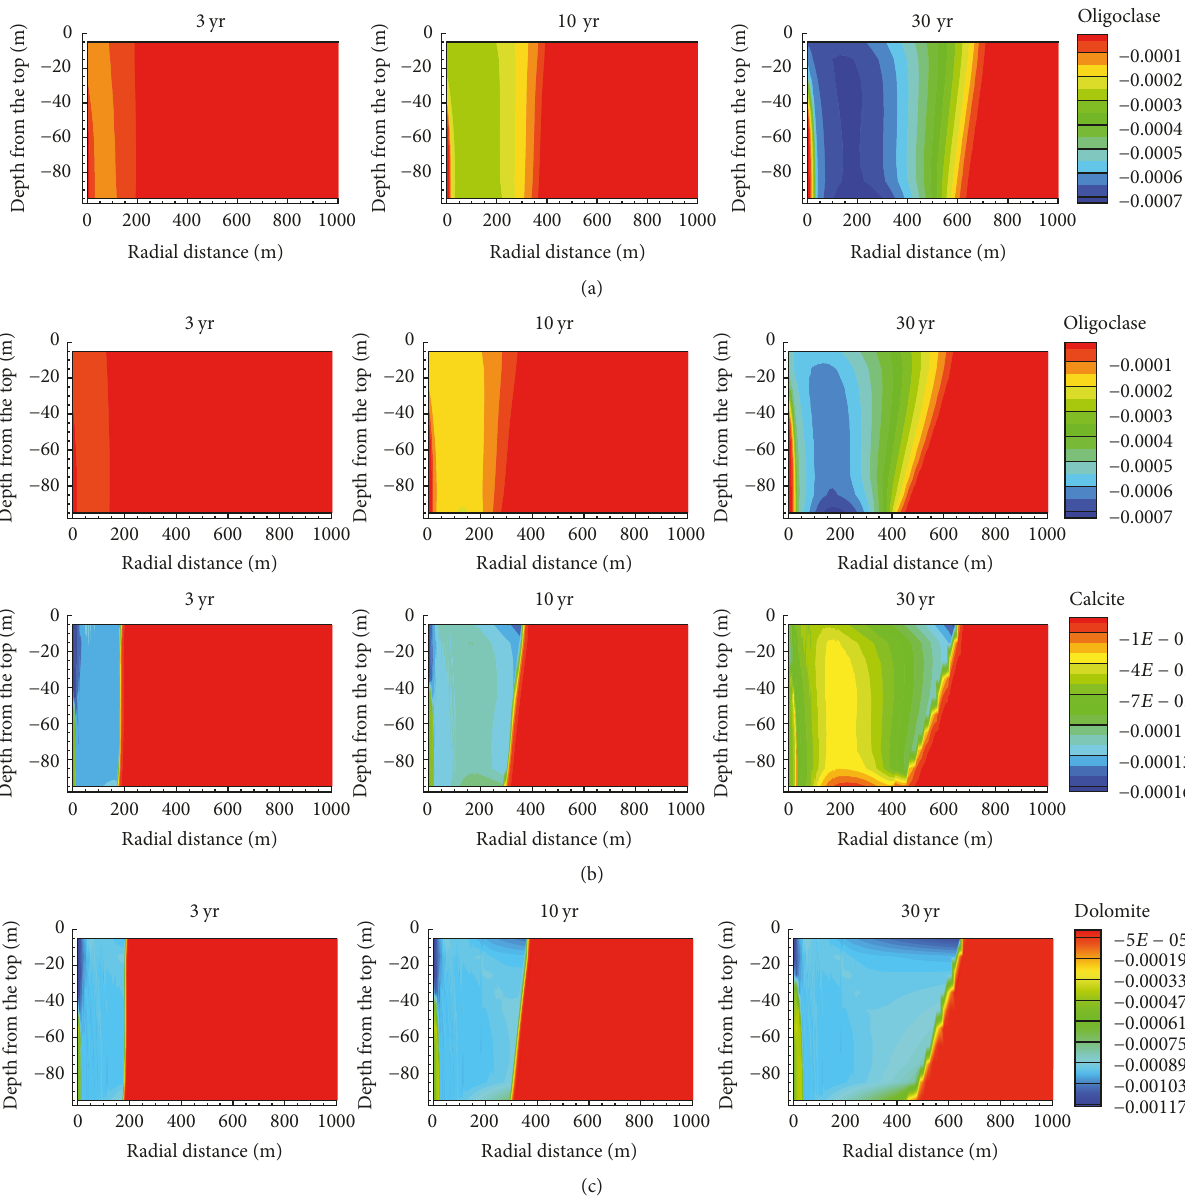
The temporal and spatial evolution of the volume fraction of key minerals within the three formations is shown in Figure 3. By analyzing the porosity changes and mineral alteration in Figures 2 and 3, it can be seen that the key minerals affecting porosity in the near-well region (zone I) are calcite and dolomite. In zone II, the dissolution of oligoclase and dolomite plays the key role in porosity increases, which is consistent with the phenomenon observed by Hao et al. [16] through the study of CO 2 -induced dissolution processes of low-permeability carbonate reservoirs. It can be concluded that oligoclase, dolomite, and calcite are the key minerals